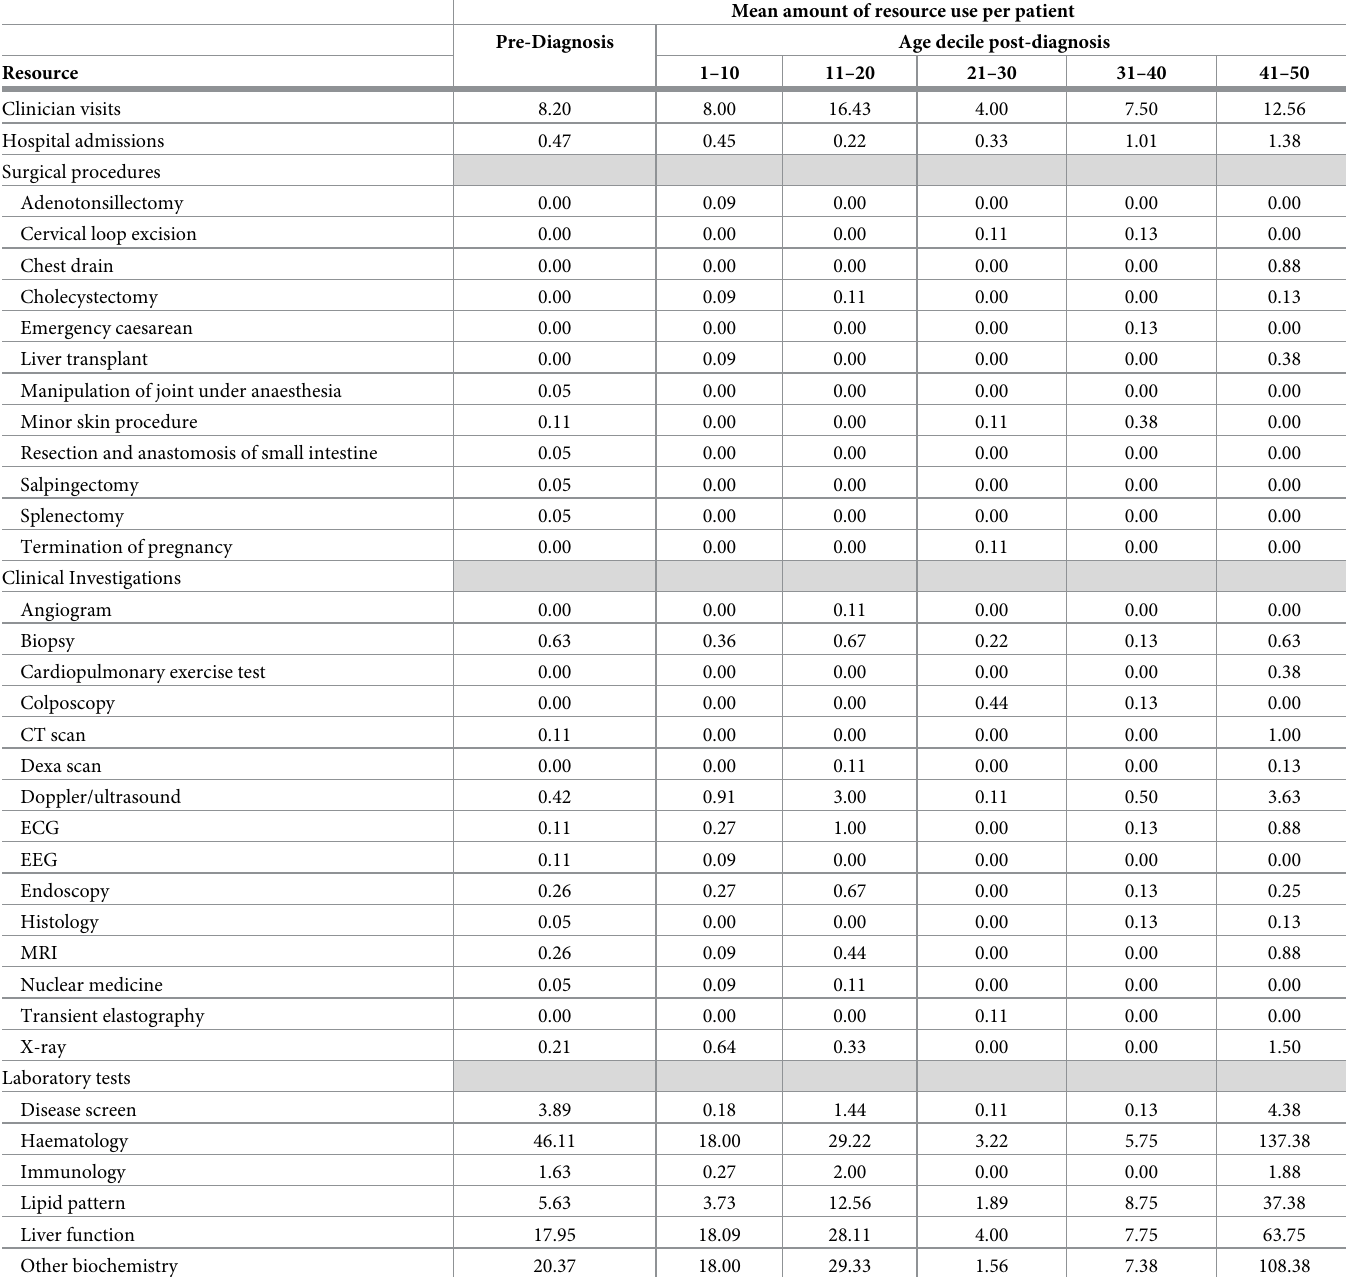
Table 4. Healthcare resource